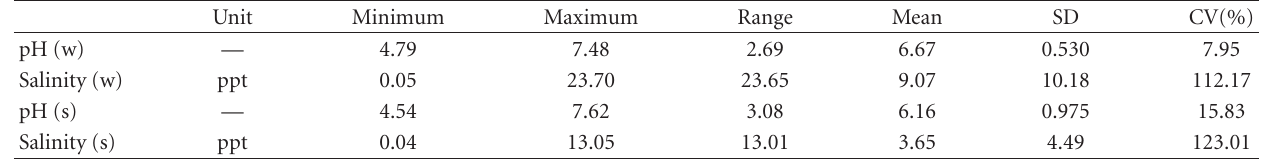
Table 4: Descriptive statistic for selected matrices of water and sediment in Langat River.